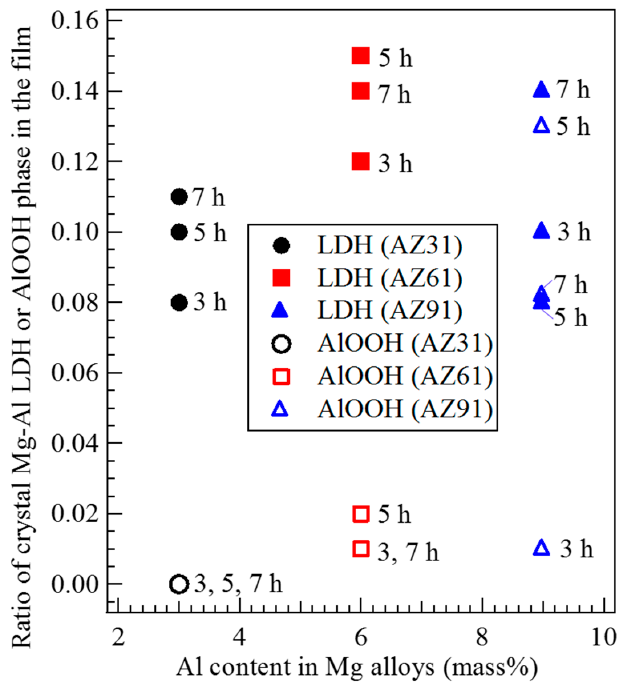
Figure 5. Relationship between the Al content in Mg alloys and the ratio of crystalline Mg-Al LDH or AlOOH phase formed in the films prepared at 423 K for 3 to 7 h. AlOOH phase formed in the films prepared at 423 K for 3 to 7